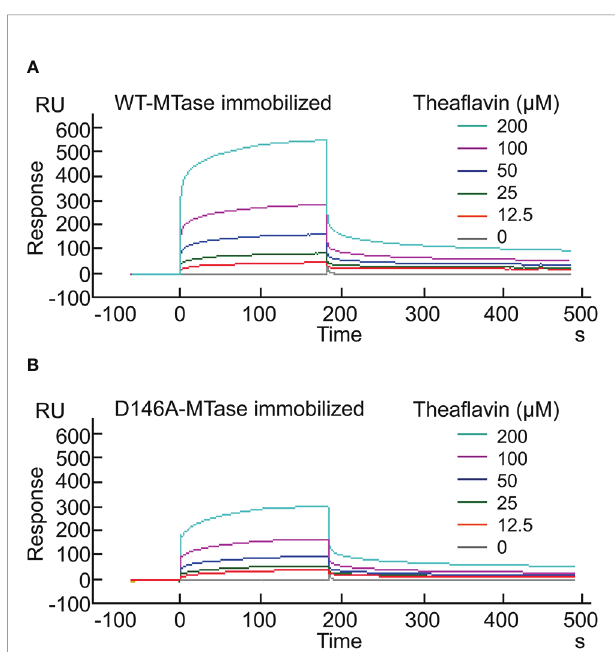
FIGURE 4 | Surface plasmon resonance analysis for the binding of thea fl avin to WT-MTase and its mutant. (A) Binding of thea fl avin to WT-MTase protein. Various concentrations (0-200 m M) of thea fl avin were injected into the chamber of a WT-MTase coated sensor chip. The change of response units (RU) is shown. (B) Binding of thea fl avin to D146A-MTase